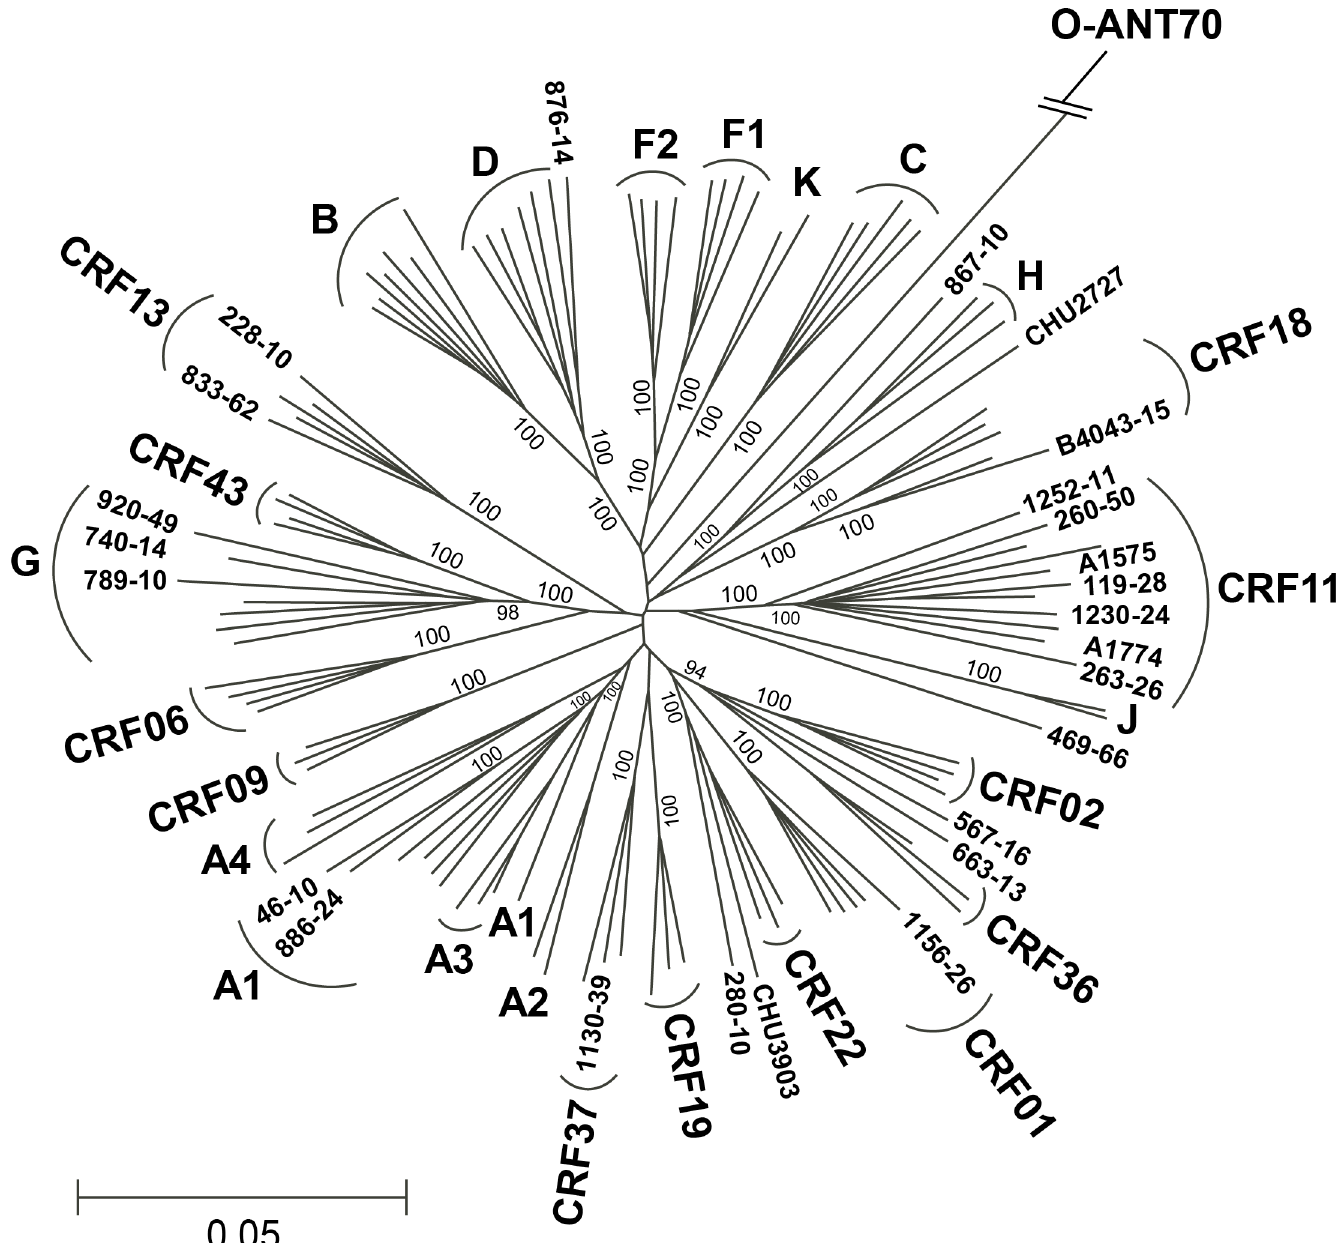
Fig 2. Phylogeny of full length genomes obtained by NGS illustrates HIV diversity in Cameroon. A phylogenetic tree of 92 HIV-1 complete genome reference sequences and 25 Cameroonian sequences was constructed from a 7387 bp gap-stripped alignment with bootstrap values indicated at each branch. Group O strain ANT70 was used as the outgroup and the genetic distance scale is